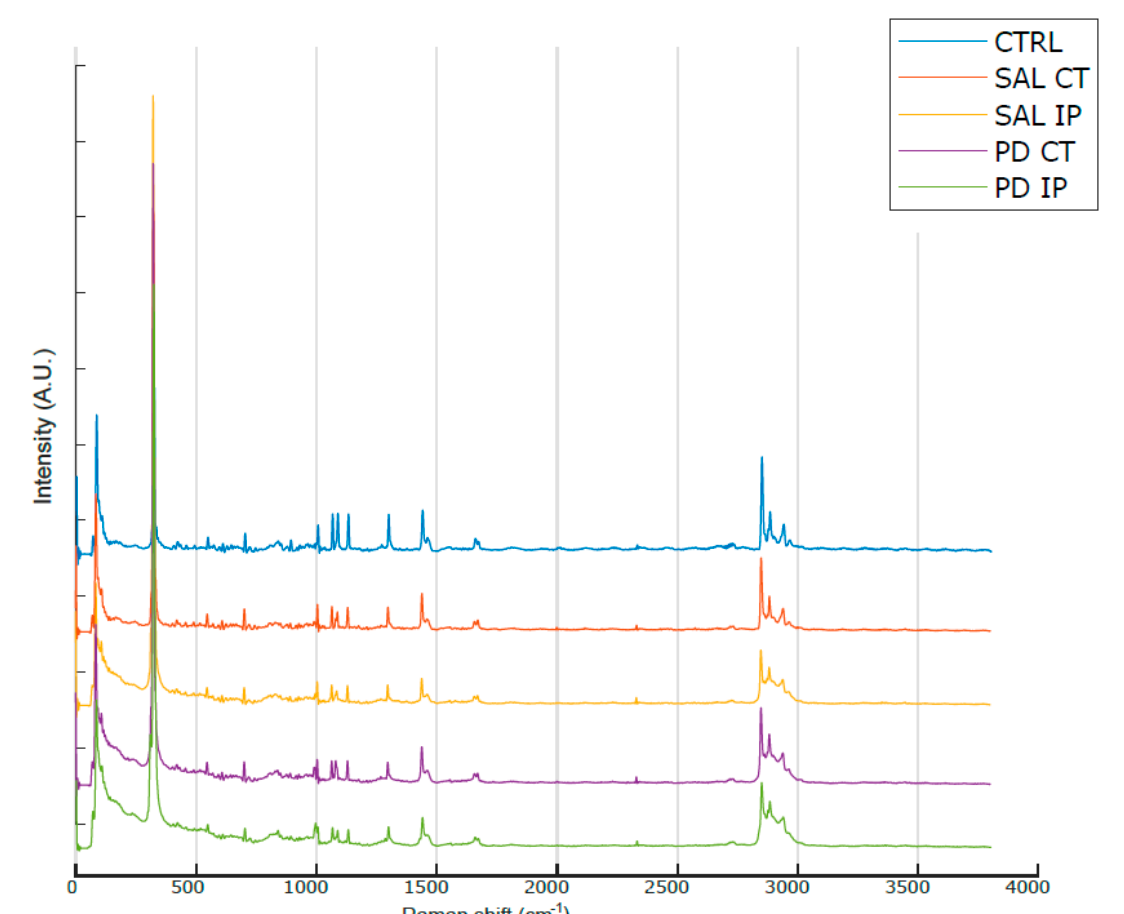
Figure 3. Average Raman spectra from the striatal decellularized matrices of the control mice and the contralateral and ipsilateral hemispheres of the saline- and 6-OHDA-lesioned mice between the range of 0 and 3800 cm − 1 . For representation purposes, Matlab 9. 4.0.813654 (R2018a). The MathWorks Inc., Natick, MA, USA, was used to obtain the average smoothed spectra with background subtraction for the striatal decellularized matrices from control mice (CTRL; total of 100 spectra in blue), saline contralateral hemisphere (SAL CT; total of 60 spectra in orange), saline ipsilateral hemisphere (SAL IP; total of 44 spectra in yellow), 6-OHDA-lesioned contralateral hemisphere (PD CT; total of 56 spectra in purple), and 6-OHDA-lesioned ipsilateral hemisphere (PD IP; total of 54 spectra in green). The spectra are offset along the intensity axis for clarity. Information on the assigned peaks can be found in Table